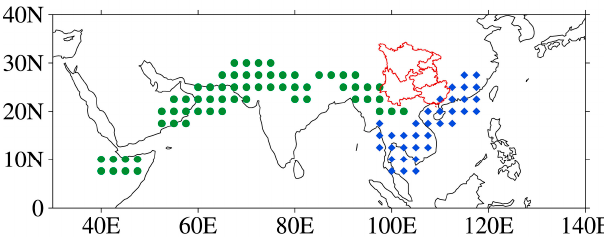
Figure 10. Example of structuring drought-related indices based on geographical anomalies (Areas I, II, and IV in Figure 5) during composite drought processes. The extracted grid points represent selected channels for index definition. Green circles and blue blocks represent the zonally less-than- normal WVT from Somalia and the meridionally less-than-normal WVT from the IndoChina- Peninsula, respectively.